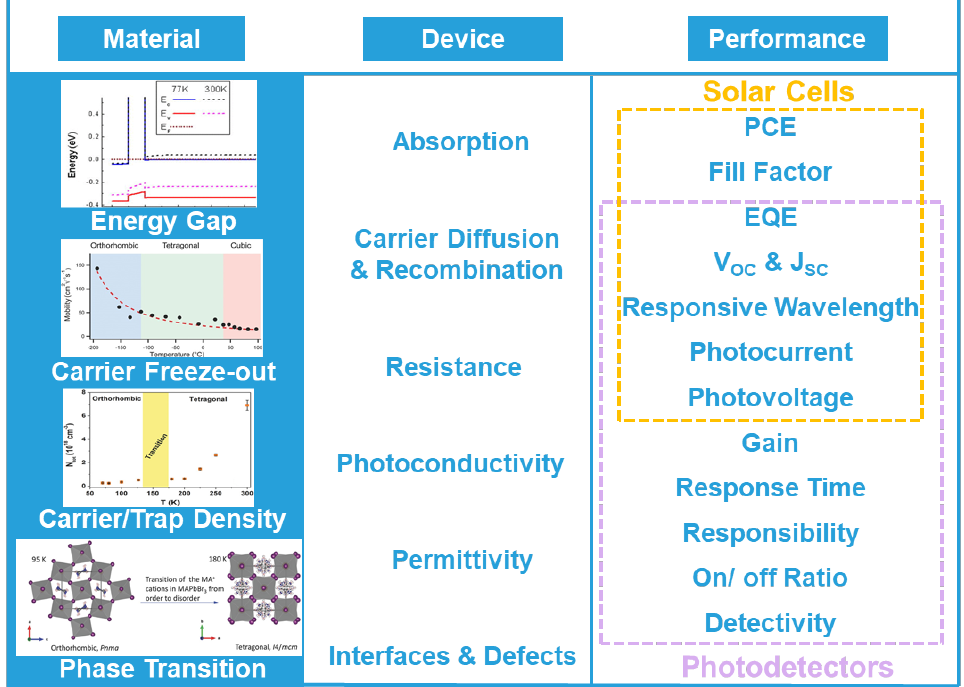
Figure 1. Temperature-dependent effect on photoelectric devices including materials, devices and performances. All images reproduced with permission: “Bandgap” (adapted from [29], with permission from the American Institute of Physics, 2014). “Carrier freeze-out” (adapted from [30], with permission from Wiley-VCH, 2015). “Carrier/Trap Density” (adapted from [31], with permission from Wiley-VCH, 2017). “Phase Transition” (adapted from [32], with permission from Wiley-VCH,